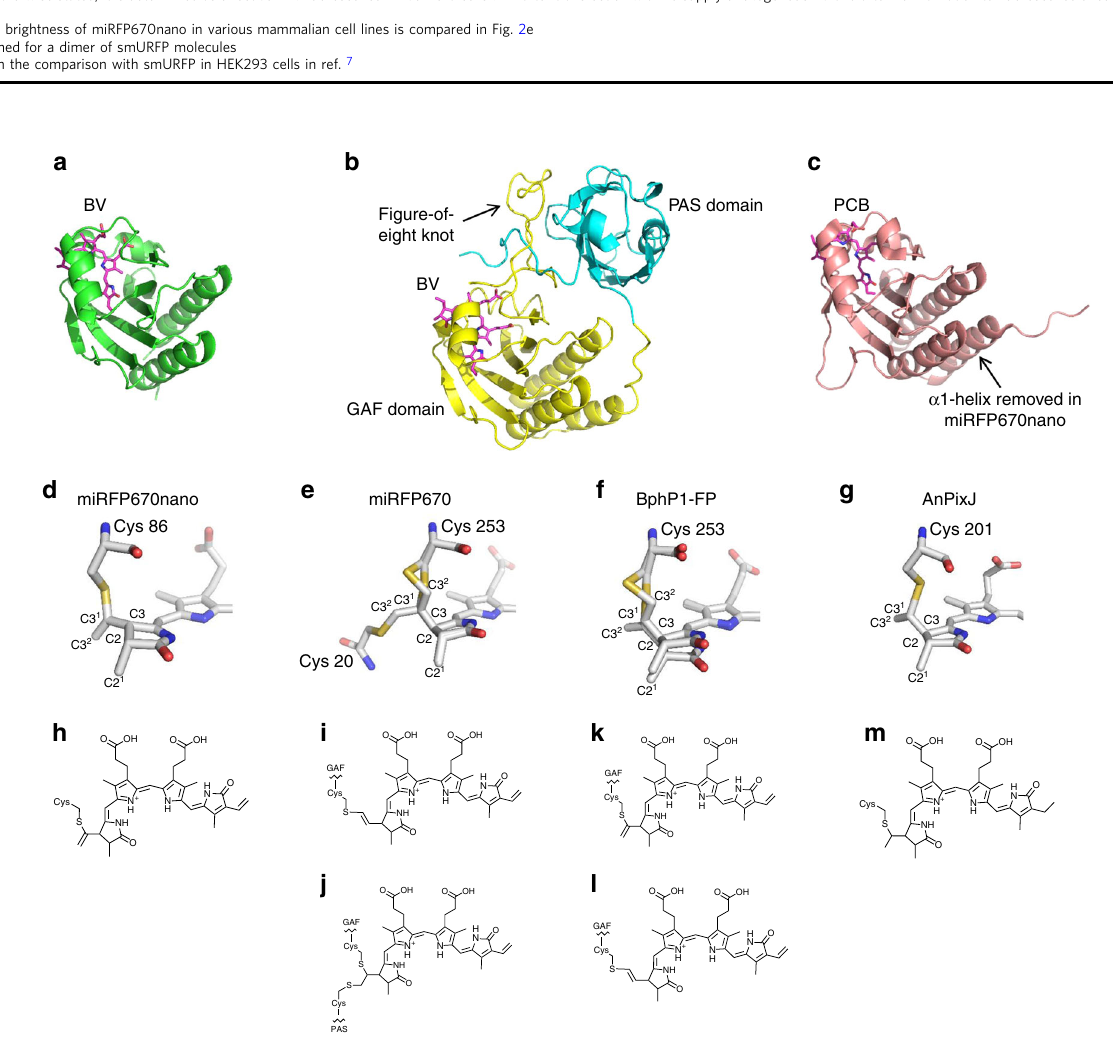
Fig. 3 Comparison of miRFP670nano, miRFP670, BphP1-FP, and AnPixJ structures and chromophores. a – c Overall structures of a miRFP670nano, b miRFP670 (PDB ID: 5VIV), BphP1-FP (PDB ID: 4XTQ), and c AnPixJ (PDB ID: 3W2Z). The BV and PCB chromophores are in magenta. α 1-Helix removed